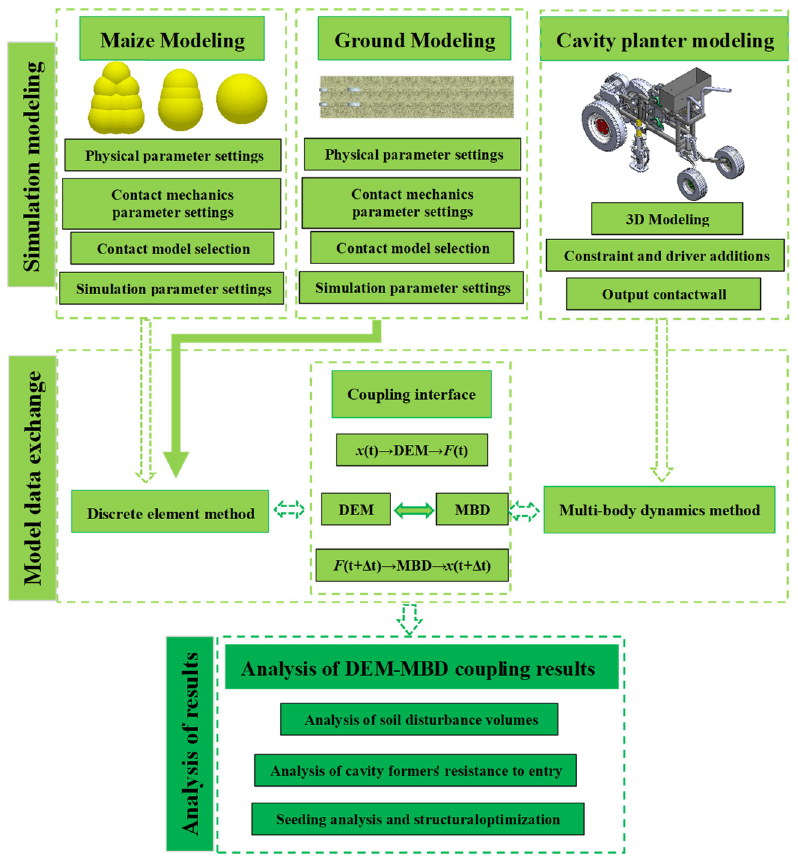
Figure 5. The flow on DEM-MBD coupling simulation.